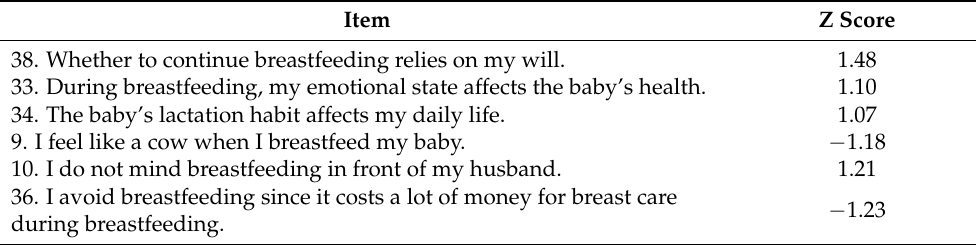
Table 3. Consensus items and average Z score ( ≥